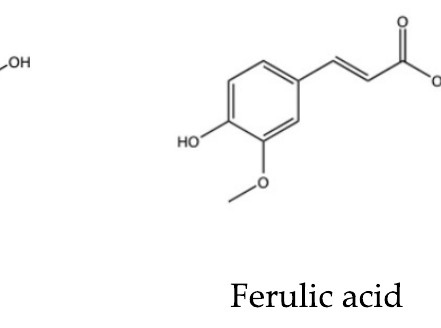
Figure 1. Structures of curcumin and ferulic acid.